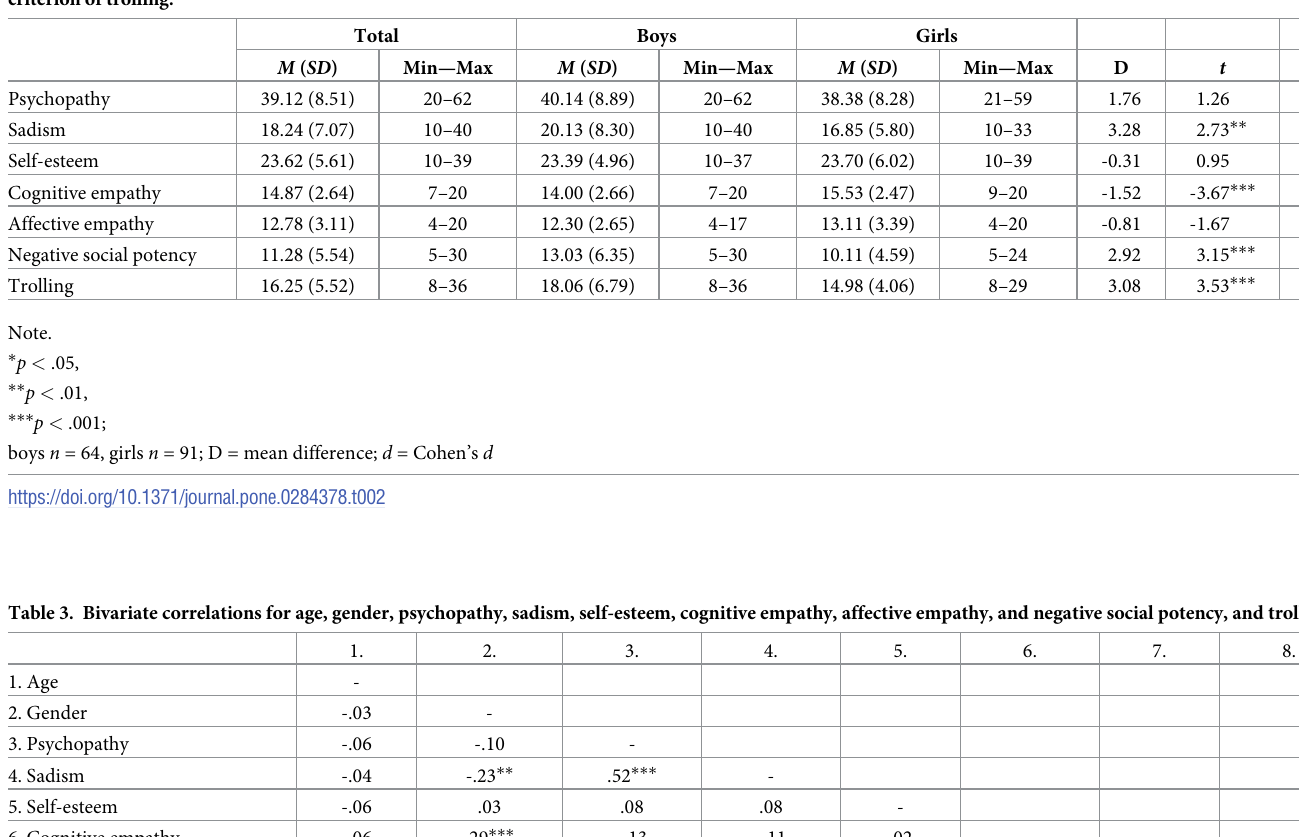
Table 2. Descriptive statistics for predictor variables of psychopathy, sadism, self-esteem, cognitive empathy, affective empathy, and negative social potency and criterion of trolling.